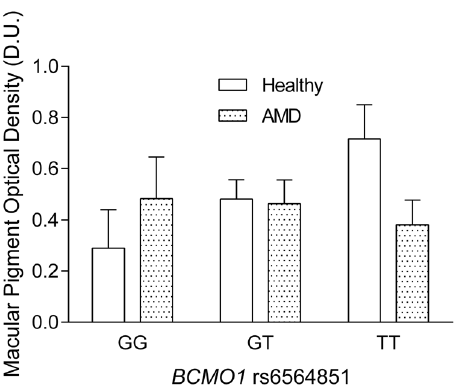
Figure 3. MPOD as a function of BCMO1 rs6564851 (error bars indicate + SD). Healthy participants with the TT genotype show on average significantly higher MPOD compared to those with the GG genotype. There were no significant differences between genotypes in the AMD group.